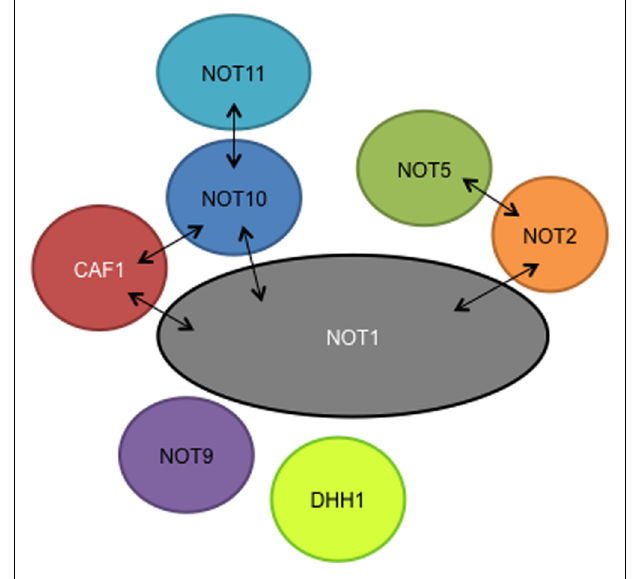
FIGURE 1 | Putative subunits of the trypanosome NOT complex, as judged by tandem affinity purification. Association of DHH1 is unclear. Two-hybrid interactions are indicated by